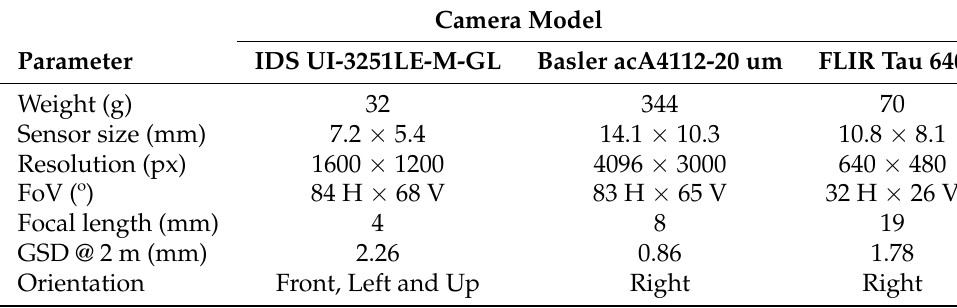
Table 1. Inspection payload sensor characteristics.